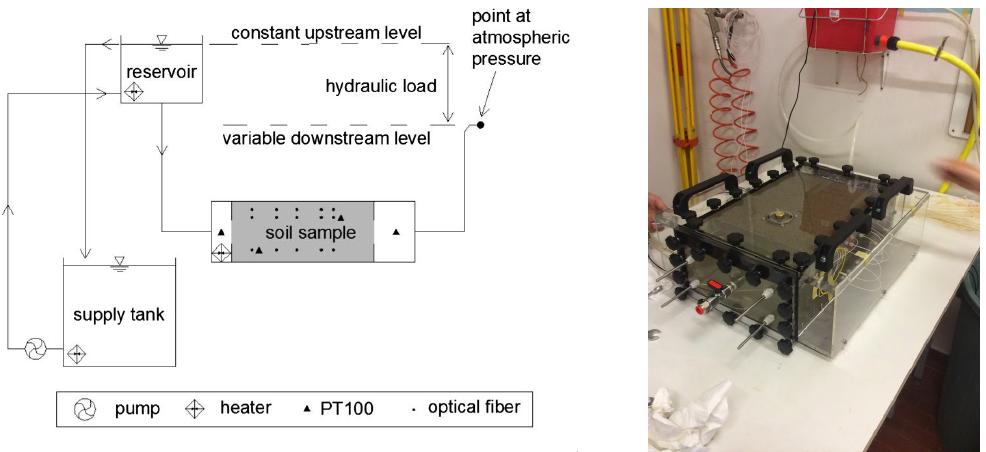
Figure 9. Left : Setup used to investigate the variations of the temperature field generated by the internal erosion in a sand box model. The optical fibre was deployed at three depths, each crossed by five fibre sections orthogonal to the flow direction and interrogated using an OFDR interrogator. Additional conventional sensors were used for comparison and pressure measurements (reproduced with permission from [136]). Right : the sand box instrumented with the optical fibre (visible on the right lateral face of the box).